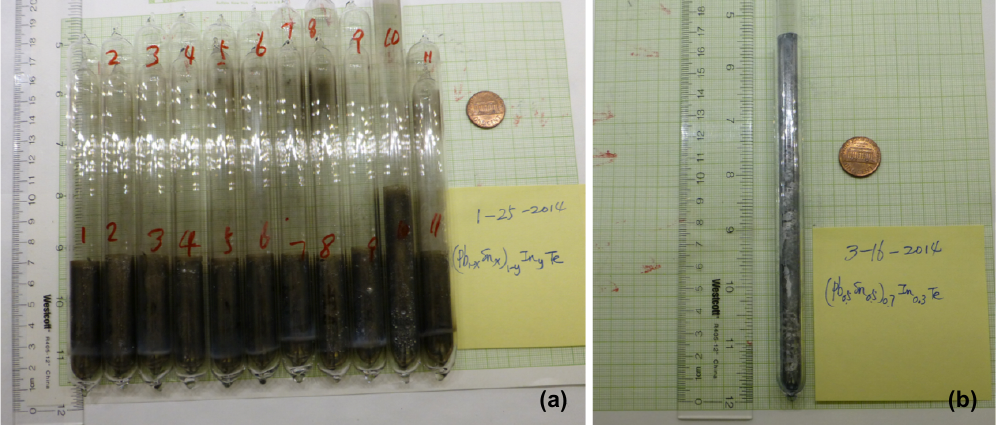
Figure 8. Single crystal rods of PSIT alloy grown by ( a ) vertical Bridgman method and ( b ) modified floating zone